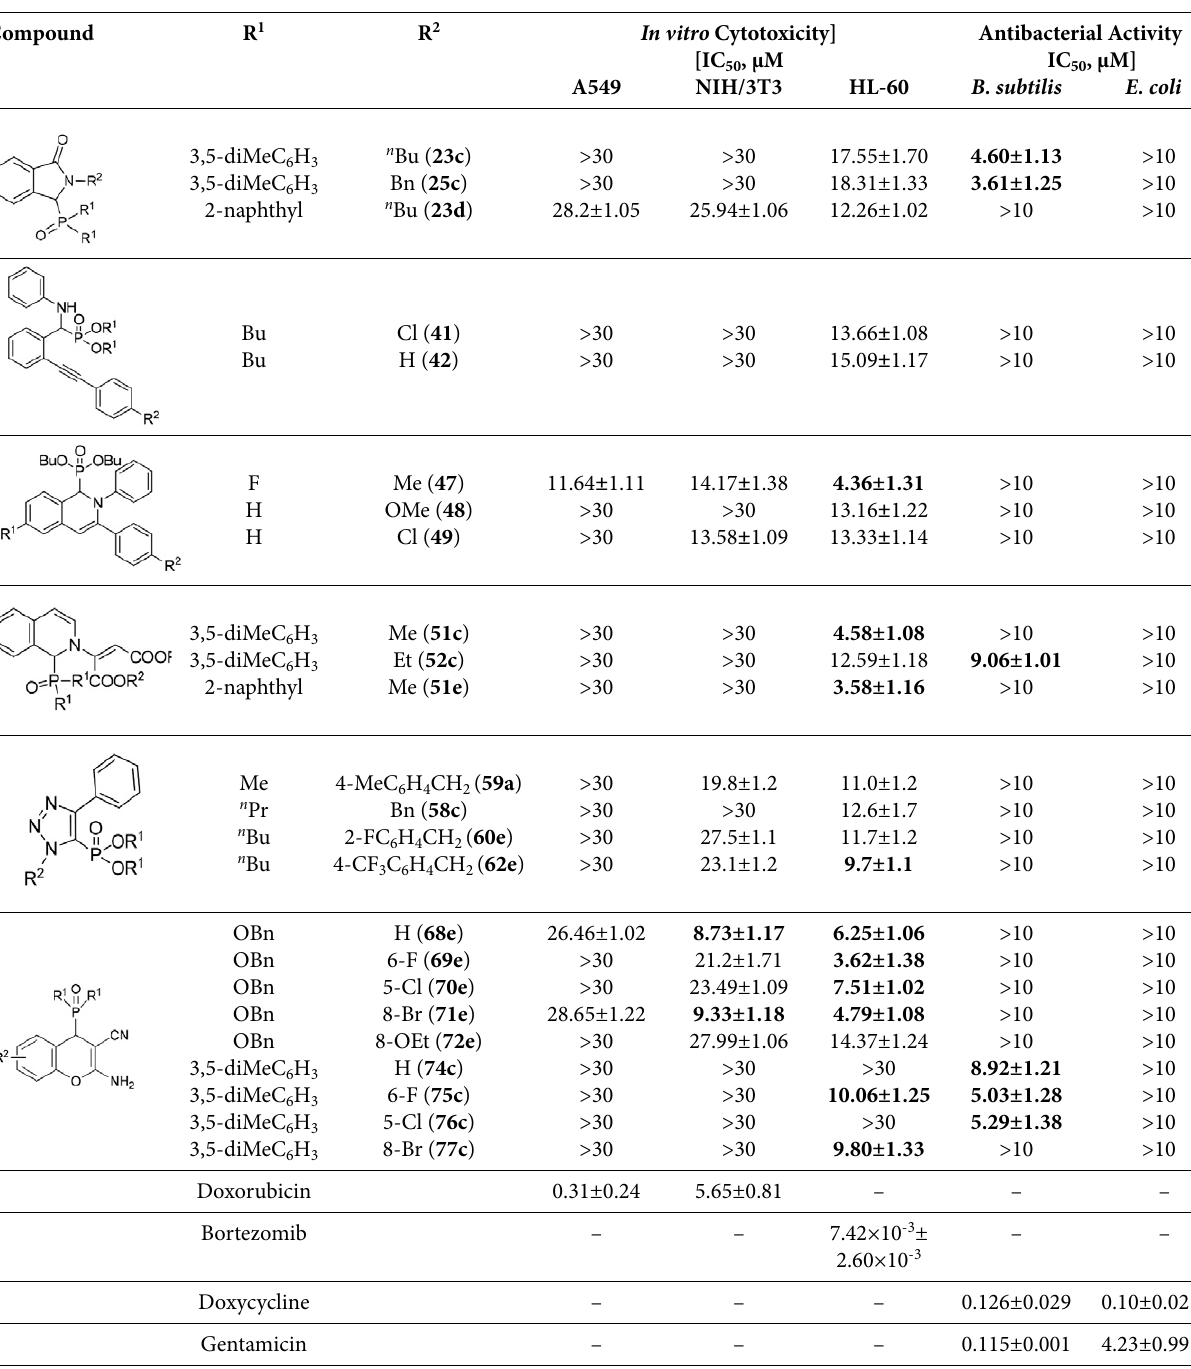
Table 2. In vitro cytotoxicity and antibacterial activity of the compounds synthesized. a